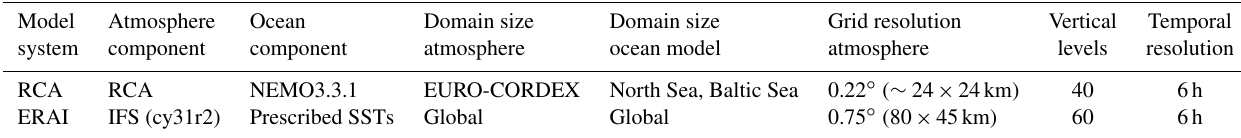
Table 1. The climate model RCA configuration employed in this study. The analyzed data set from the ERAI reanalysis is also shown (Dee et al., 2011).